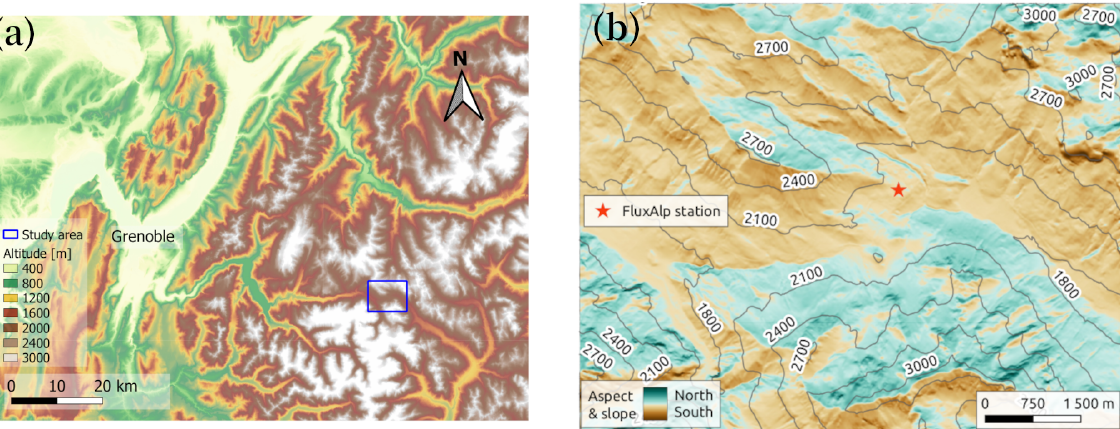
Figure 3. Location of the study area around the Col du Lautaret alpine site. The blue rectangle in (a) represents the extension of the study area, shown in (b) . The domain is generated from the RGE ALTI®Version 2.0 digital elevation model (DEM) provided by IGN France at a spatial resolution of 5m and resampled to 10m for this study. Slope angle is represented by the intensity of the